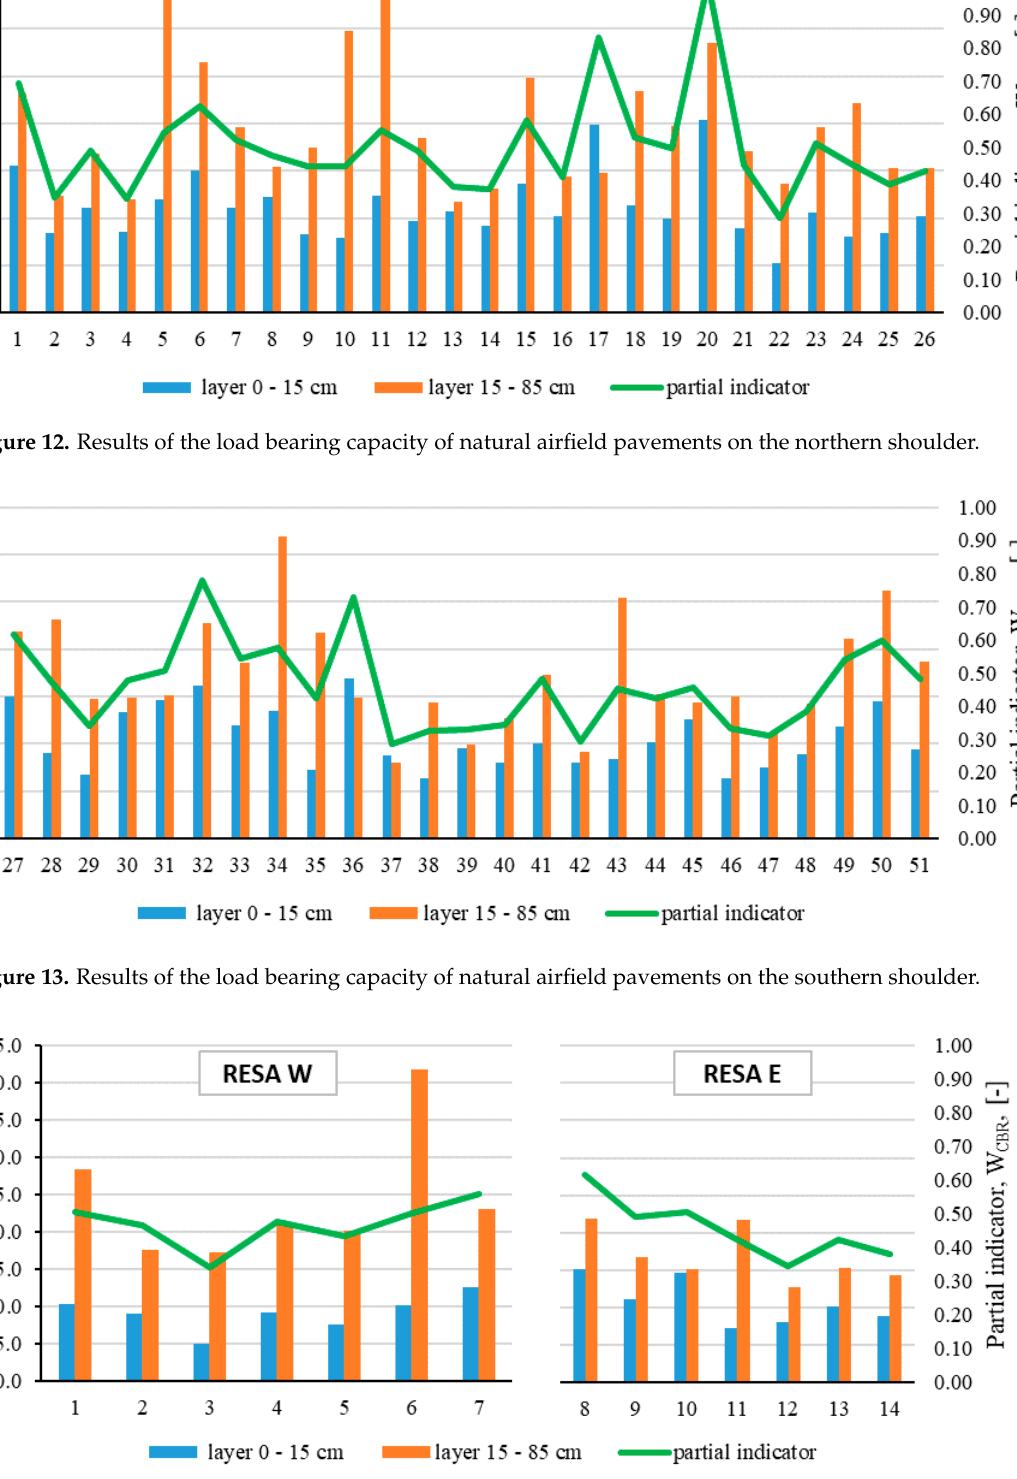
Figure 14. Results of the load capacity of natural airport pavements on the runway end safety areas. Table 7. Average values of the load bearing capacity and the calculated CBR average of the ana- lyzed AFE pavements.